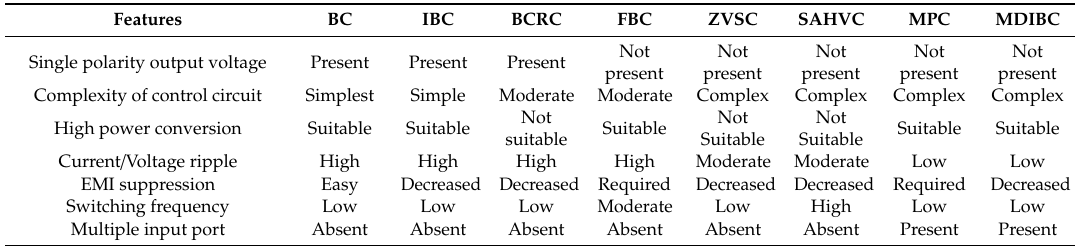
Table 6. Features comparison of DC-DC converter